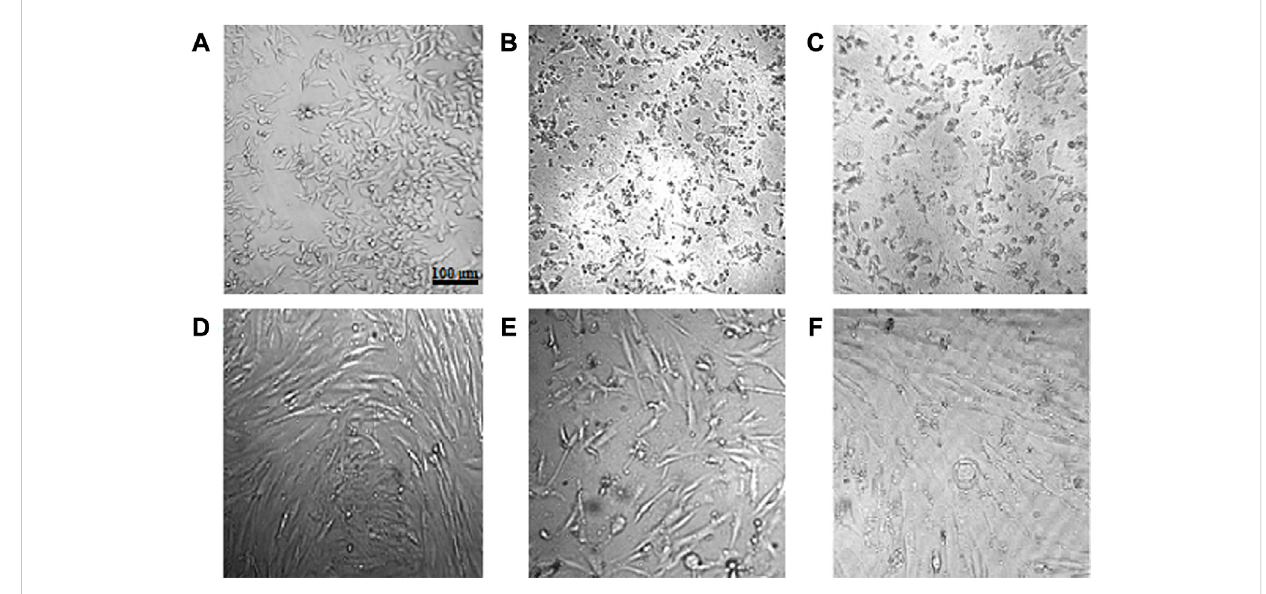
FIGURE 9 Morphological alterations of cells after administration of crude and calcined CuONPs. Phase contrast photomicrographs of LoVo (A – C) and HDF (D – F) cells; untreated (A, D) , treated with 200 μ g/mL crude (B, E) and calcined (C, F) CuONPs.